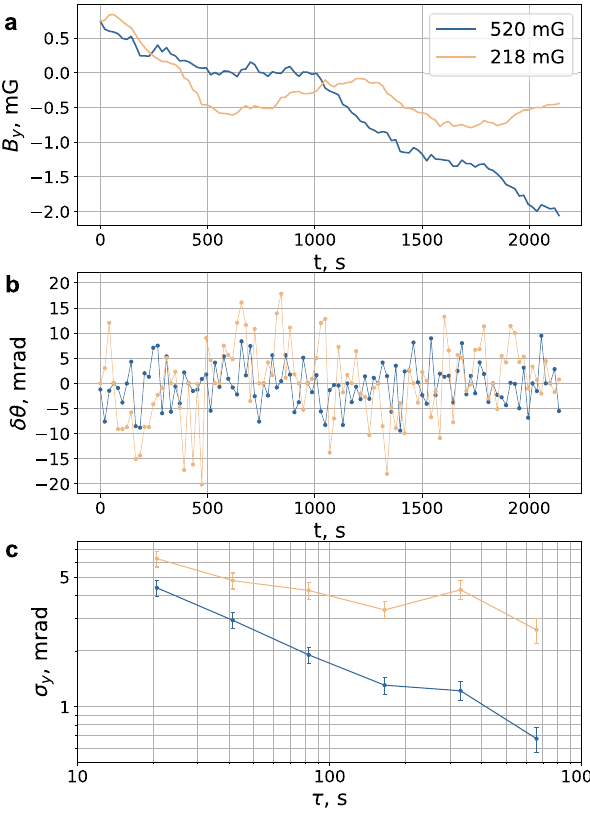
Fig. 4 Stabilization of the bias magnetic fi eld direction. a Compensation fi eld B y as a function of time for one measurement run. The orange line corresponds to the data points with the “ reference ” fi eld B r the blue line to the points with the “ main ” fi eld B m δθ over the measurement run. c Allan deviation for δθ data sets from ( b ). Error bars correspond to 1 s.d. statistical